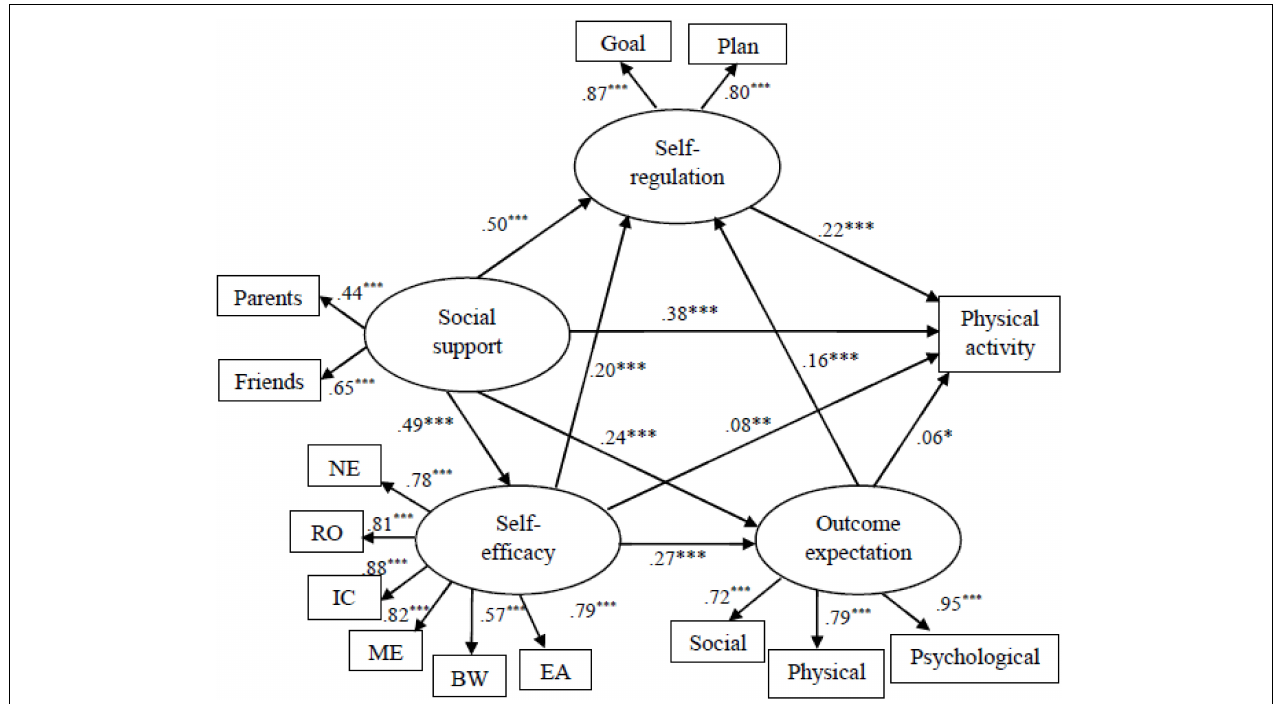
FIGURE 1 | The structural equation model of the overall sample. NE, negative effects; RO, resistance of others; ME, making excuses; BW, bad weather; EA, exercising alone; IC, inconveniency. * indicates p < 0.05, ** indicates p < 0.01, *** indicates p <